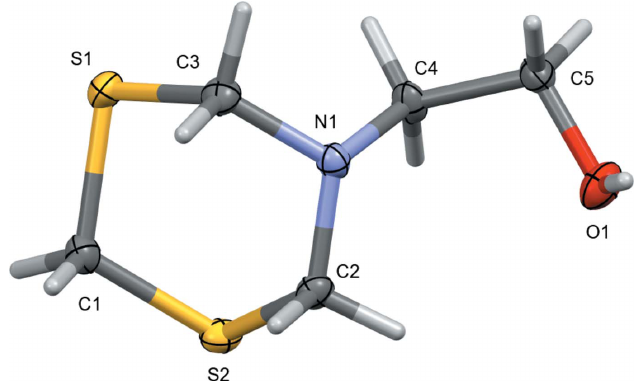
Figure 2 The molecular structure of 2-(1,3,5-dithiazinan-5-yl)ethanol. Displace- ment ellipsoids are shown at the 50% probability level.